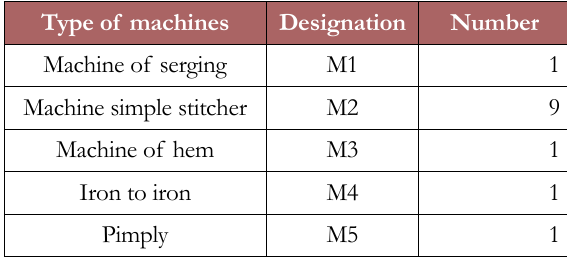
Table 5. Number of